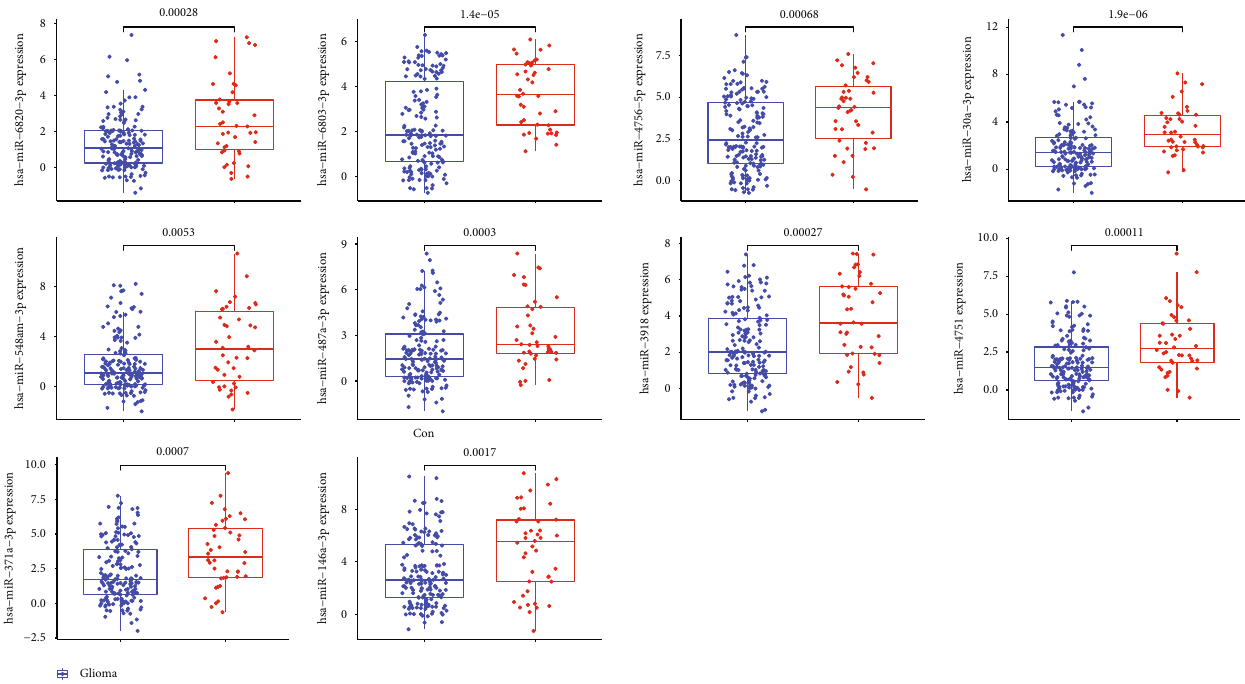
Figure 3: The expression pattern of miR-6820-3p, miR-6803-3p, miR-30a-3p, miR-4751, miR-3918, miR-146a-3p, miR-548am-3p, miR- 371a-3p, hsa-miR-487a-3p, and hsa-miR-4756-5p in PCNSL and glioma